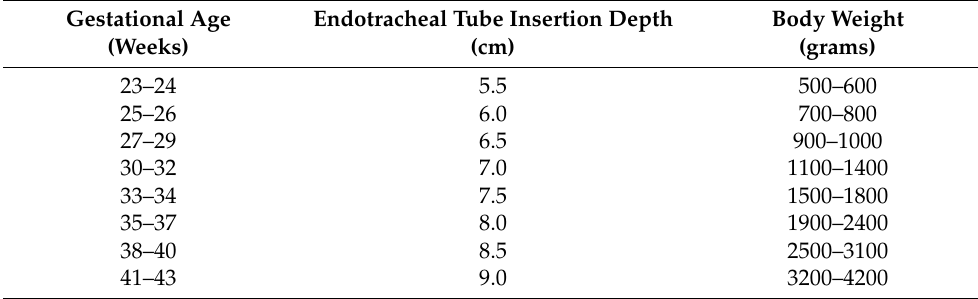
Table 1. Initial recommended endotracheal tube insertion depth for